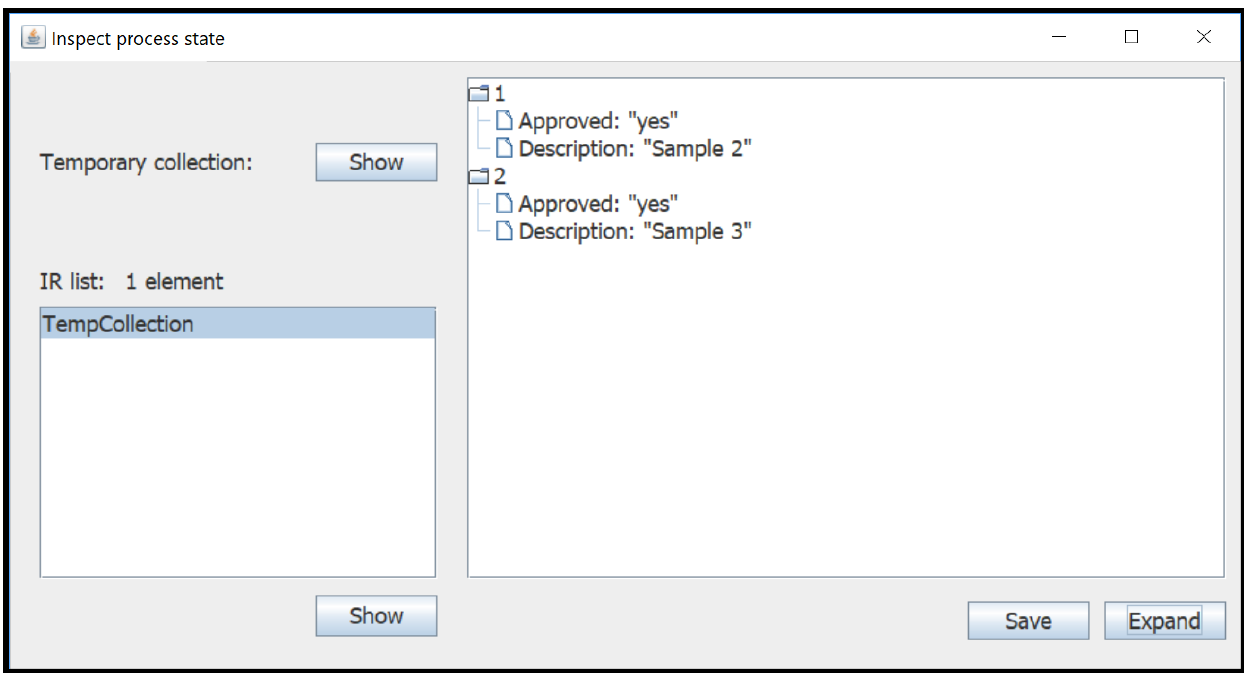
Figure 6. Inspection window of the J-CO-UI